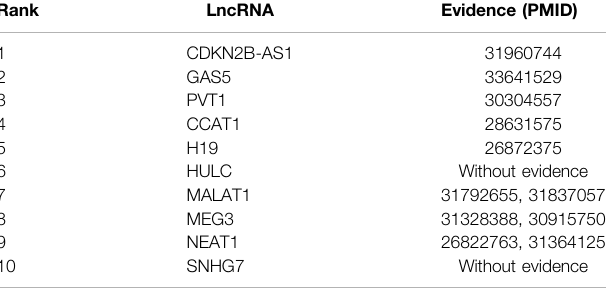
TABLE 5 | Case study results of laryngeal cancer.